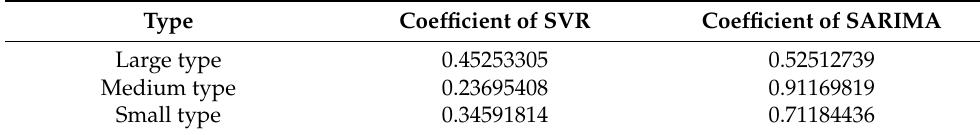
Table 8. Optimized coefficients of the modified